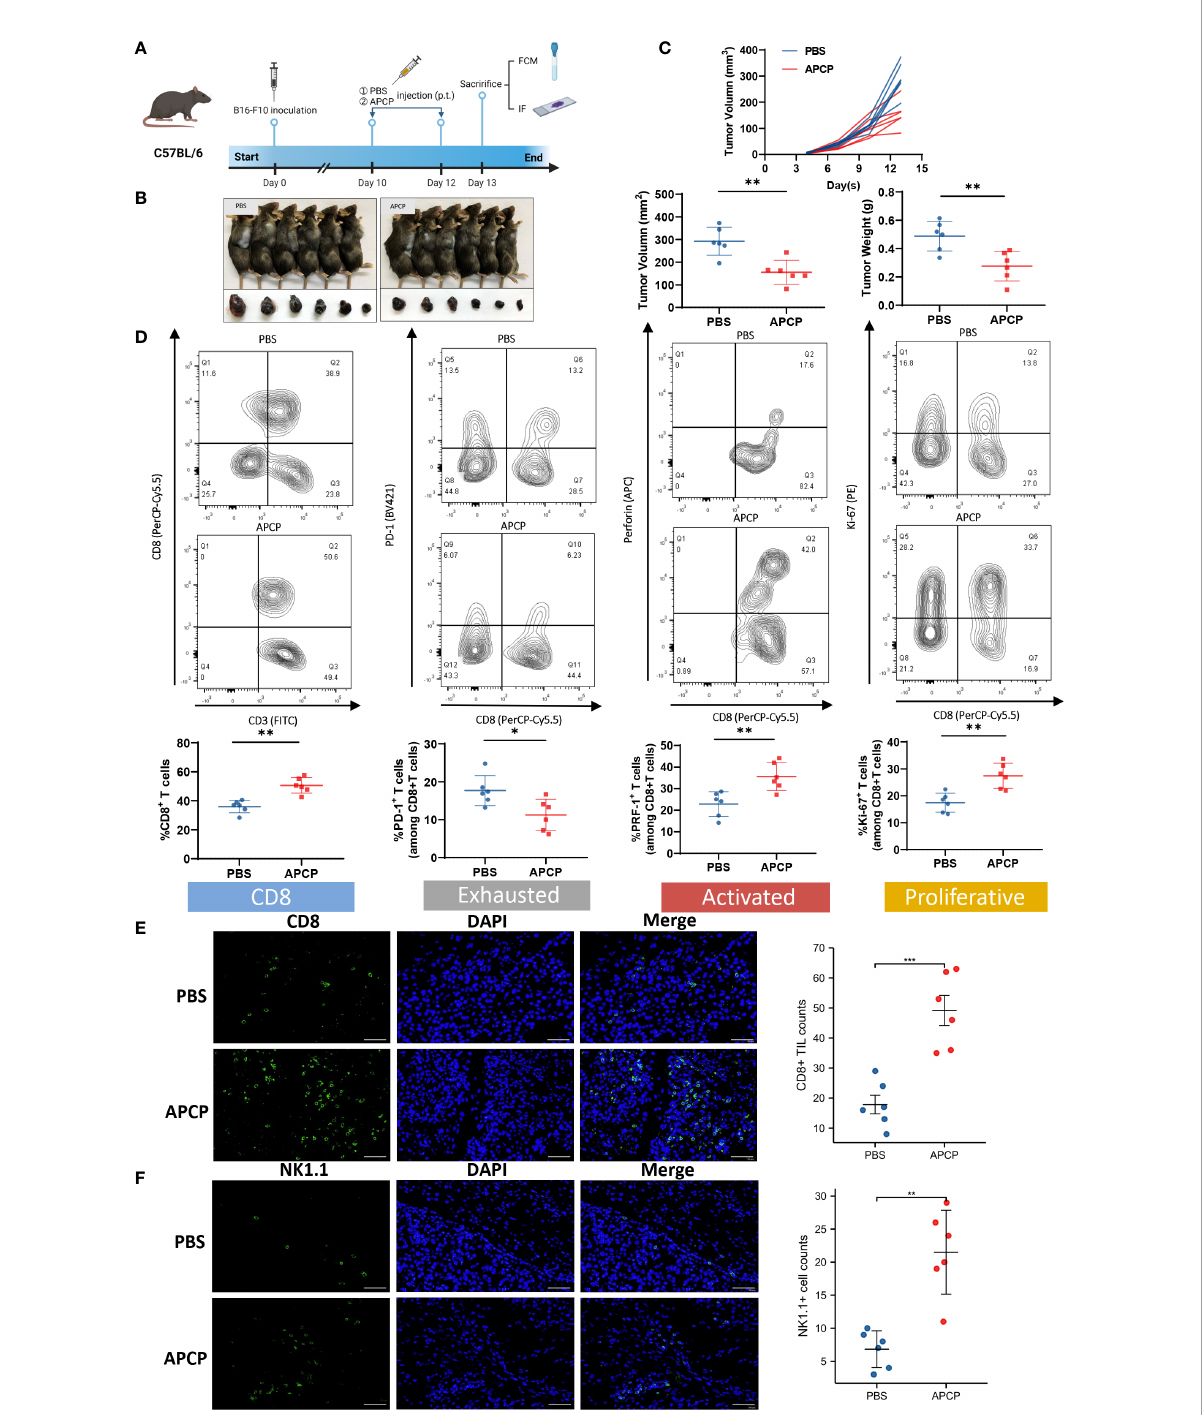
FIGURE 6 The function of CD73 inhibitor APCP on tumor growth and CD8 + T cell in fi ltration. Tumor xenografts of C57BL/6 mice by using B16-F10 cells were treated with PBS or CD73 inhibitor APCP (A – C) . CD8 + T cell in fi ltration level in PBS/APCP subgroup. Expression of immune exhausted markers, activated markers and proliferative markers for total CD8 + T cells in PBS/APCP subgroup (D) . CD8 + T cells and NK1.1 + cells in fi ltrated in tumors treated with PBS and APCP (E, F) . *p<0.05; **p<0.01;